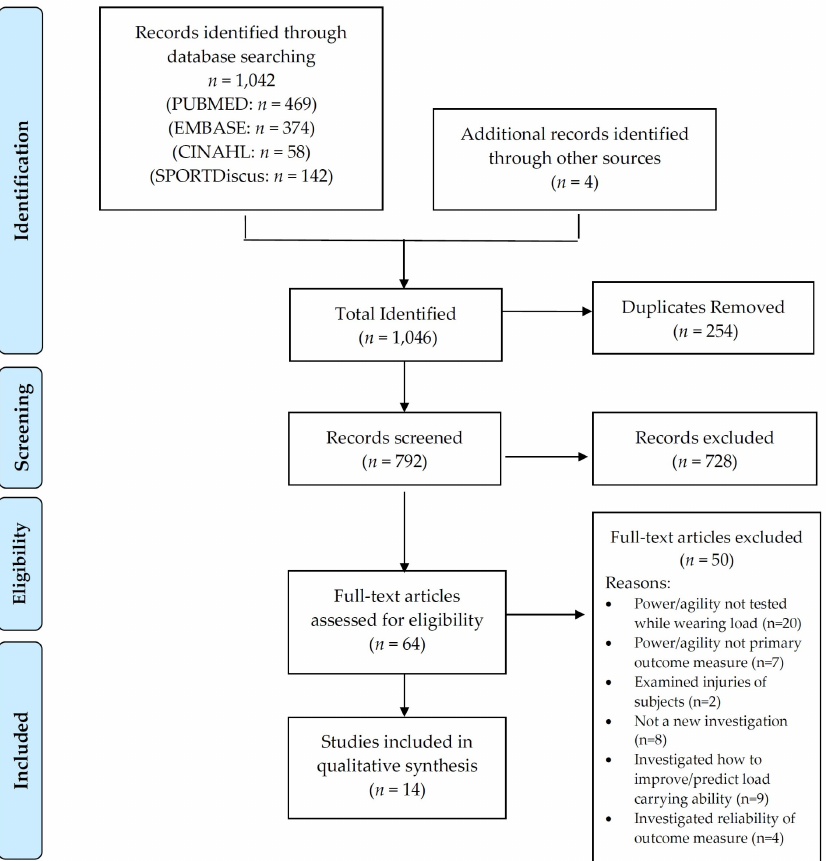
Figure 1. PRISMA diagram detailing the screening process of the literature